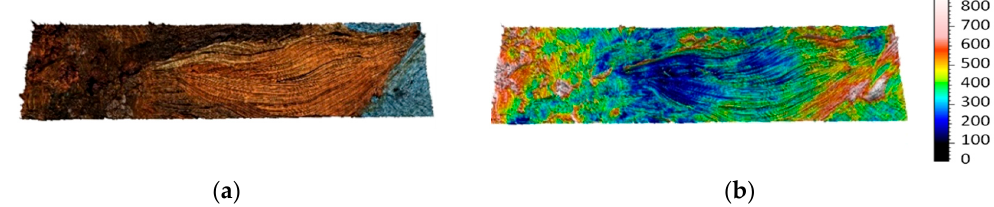
Figure 9. Topographic digital model of a centimeter scale region (8 × 2 cm)—focus variation measurements: ( a ) surface topography with image and ( b ) surface topographic map.